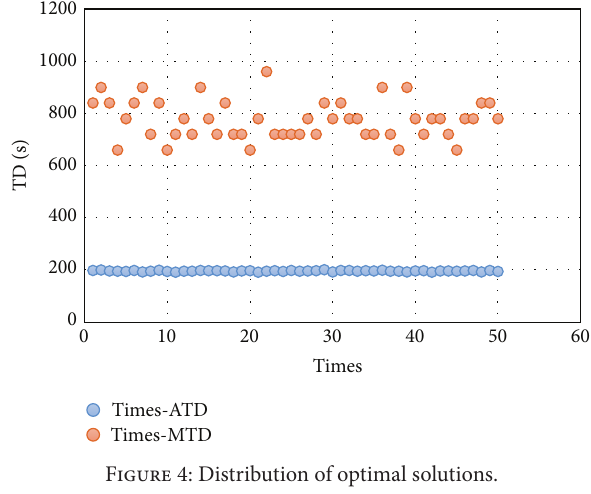
Figure 4: Distribution of optimal solutions.